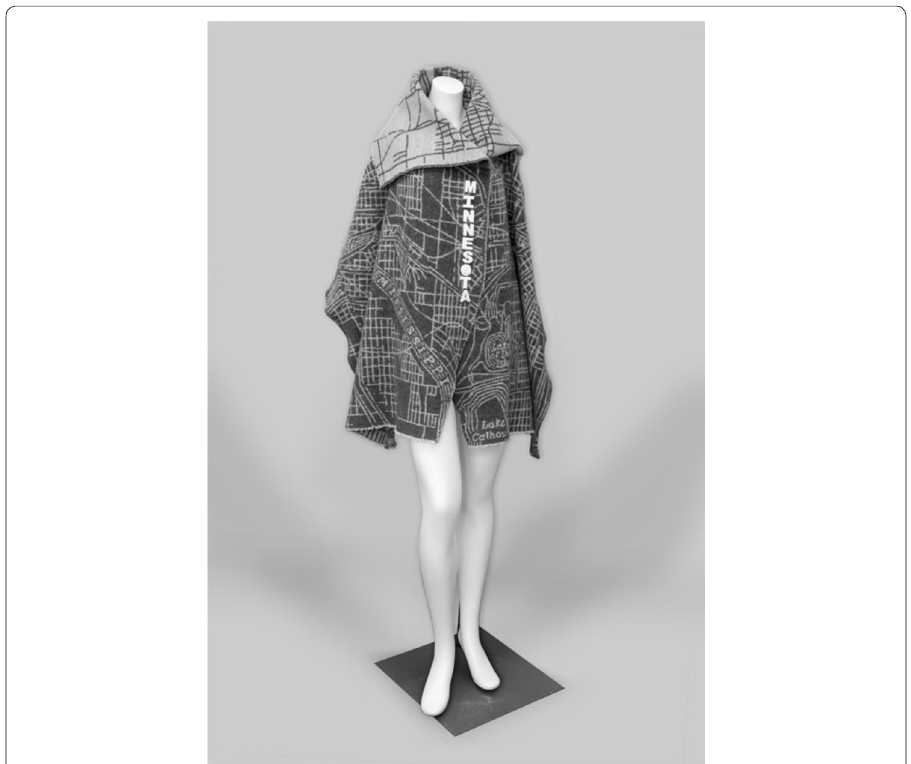
Fig. 1 3D Printed buttons attached on a cape (white PLA